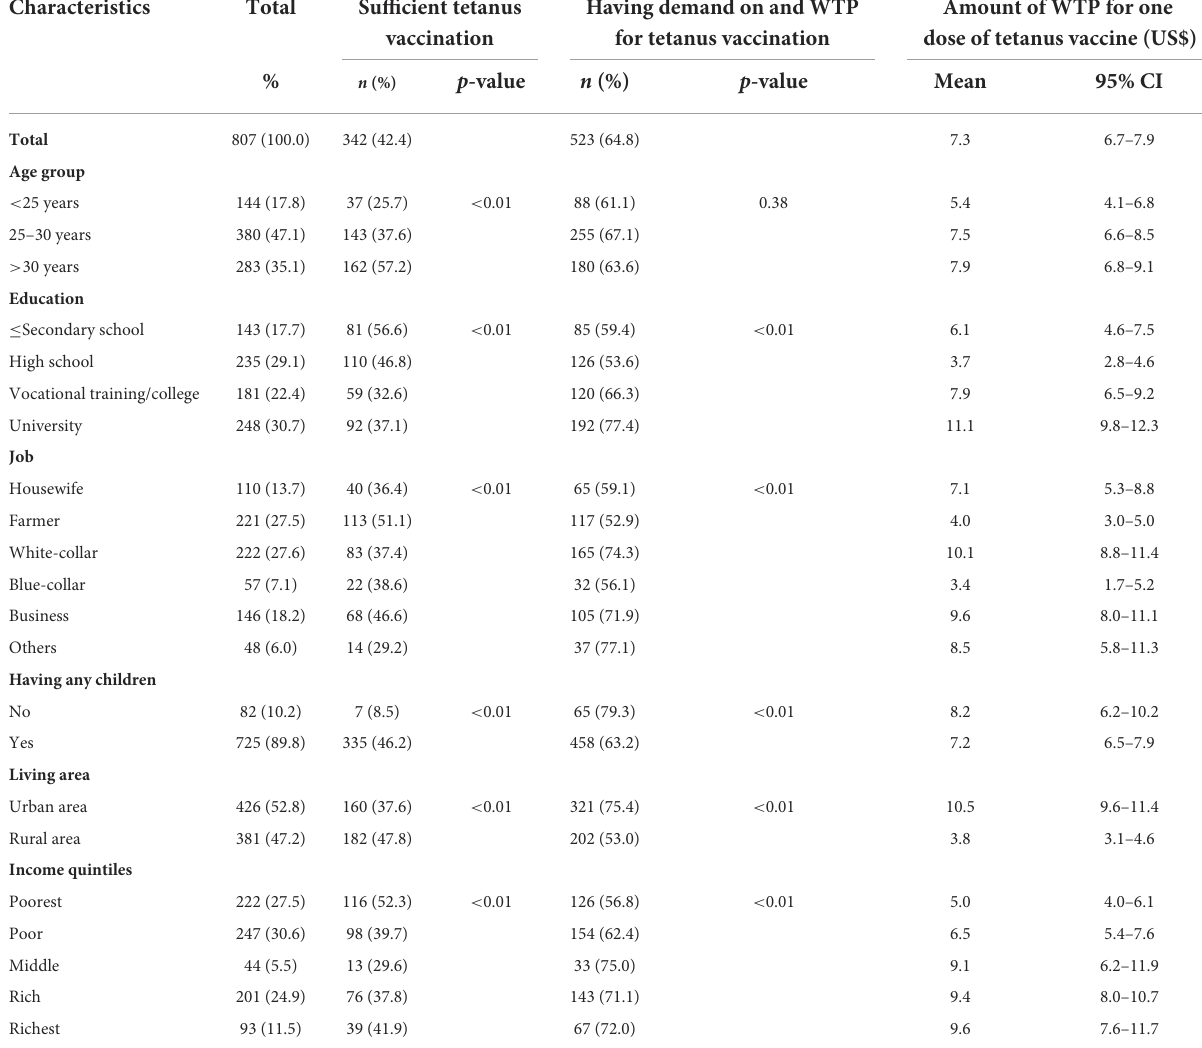
TABLE 1 Tetanus vaccination uptake, demand, and WTP by sociodemographic characteristics. Characteristics Sufficient tetanus Having demand on and